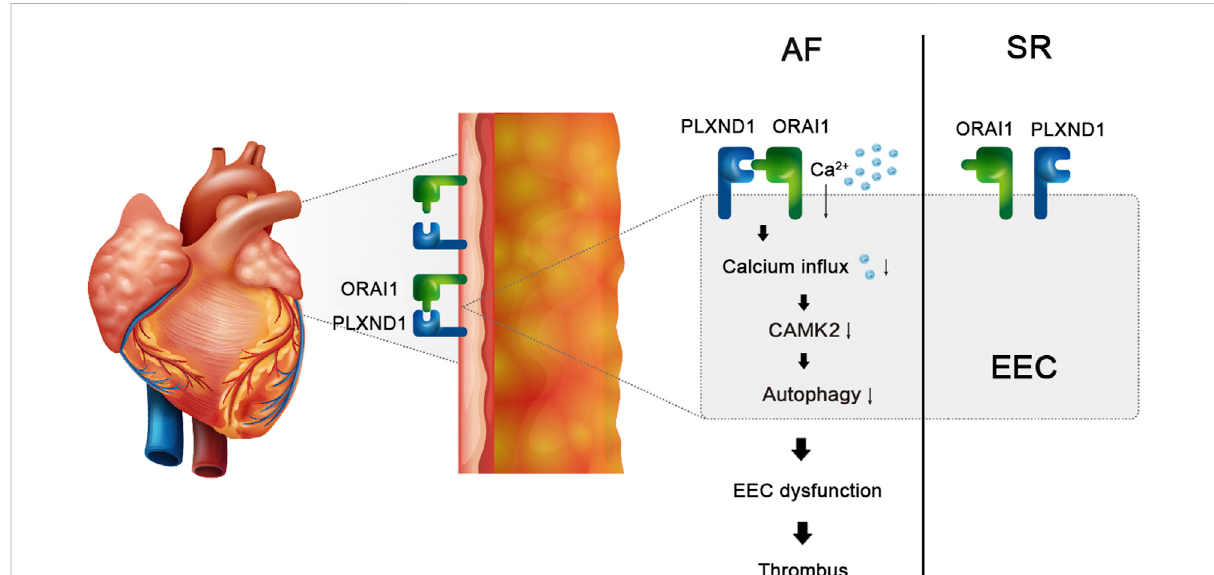
FIGURE 6 Schematic fi gure. The expression of the mechanosensitive protein PLXND1 was increased in the cytomembranes of EECs during AF, which served as a scaffold protein to bind with ORAI1 and decreased ORAI1-mediated calcium in fl ux. Decreased calcium in fl ux-mediated phosphorylation of CAMK2 is associated with the inhibition of autophagy and results in EEC dysfunction in